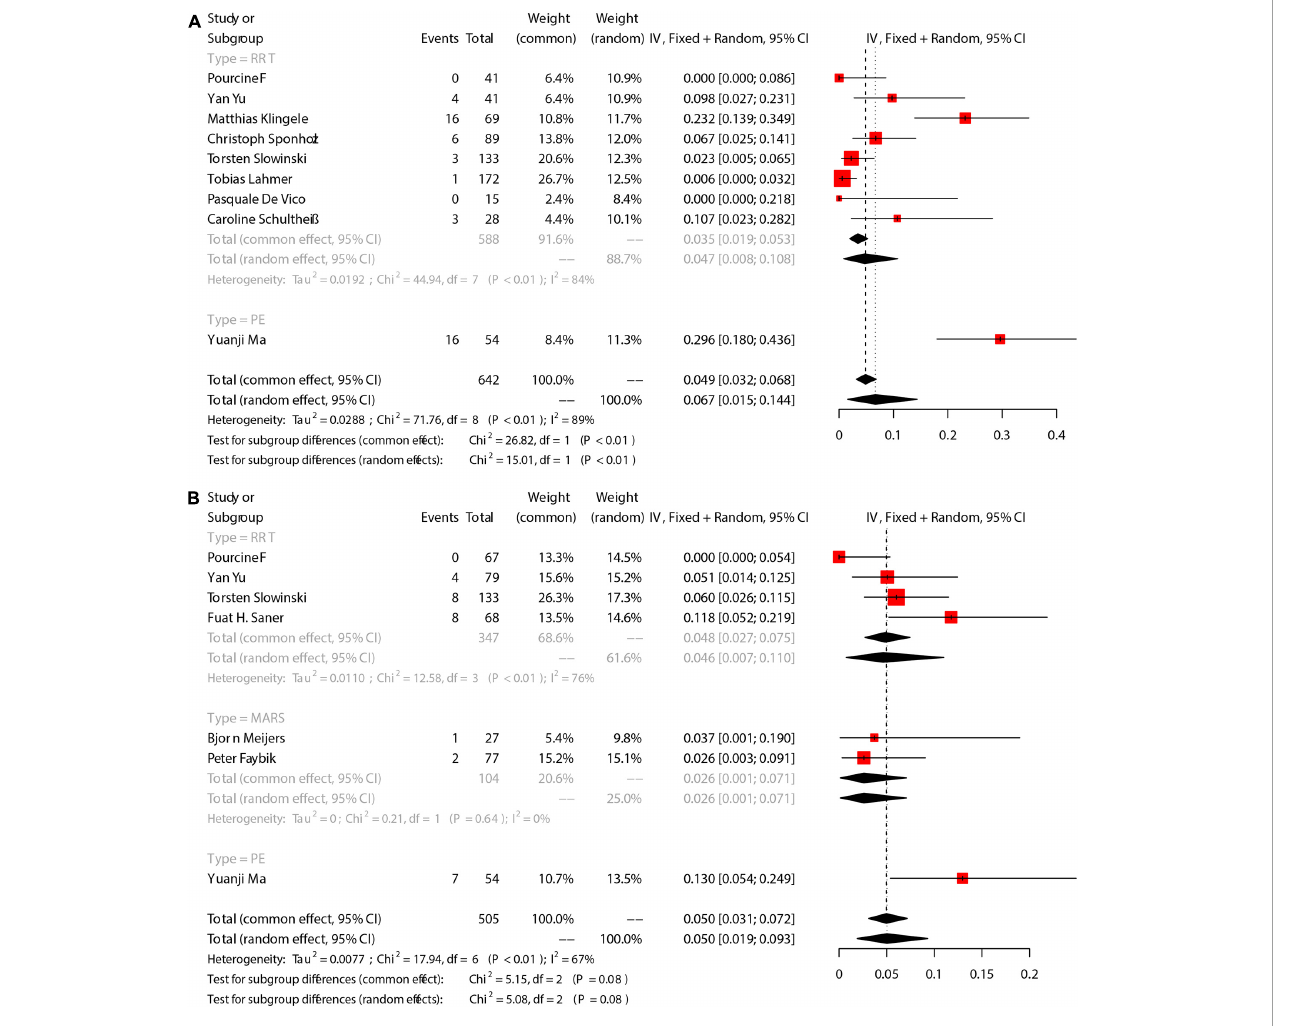
FIGURE3 The pooled rates (95% CI) of Citrate accumulation (A) and bleeding (B) . RRT, renal replacement therapy; MARS, molecular adsorbent recirculation system; PE, plasma exchange; CI, confidence